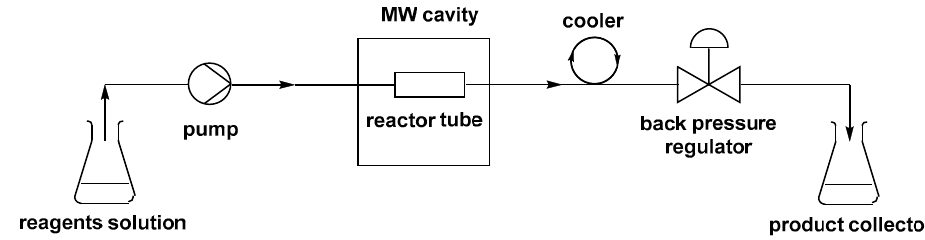
Figure 2. Schematic drawing of continuous flow microwave (MW) systems.